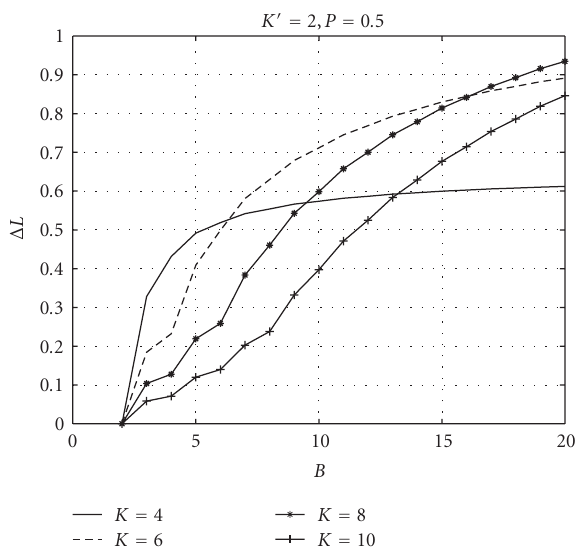
Figure 6: Δ L versus B for di ff erent K , for K (cid:5) = 2 and P = 0 .